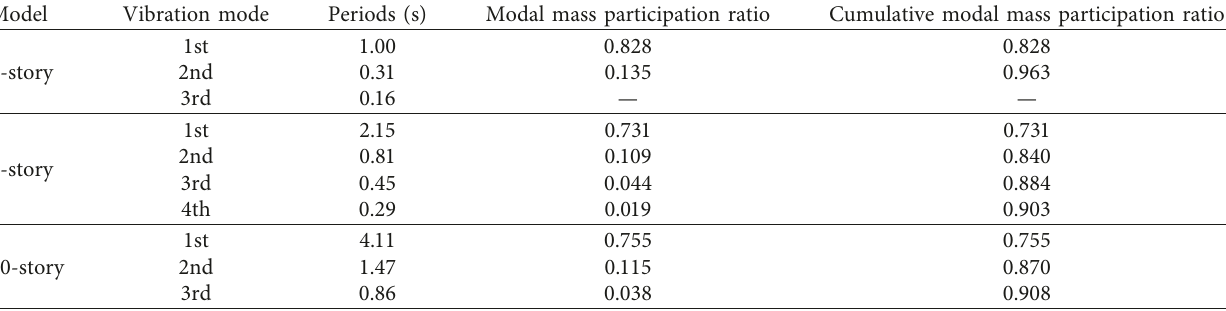
Table 1: Vibration periods of the 3-, 9-, and 20-story structures.